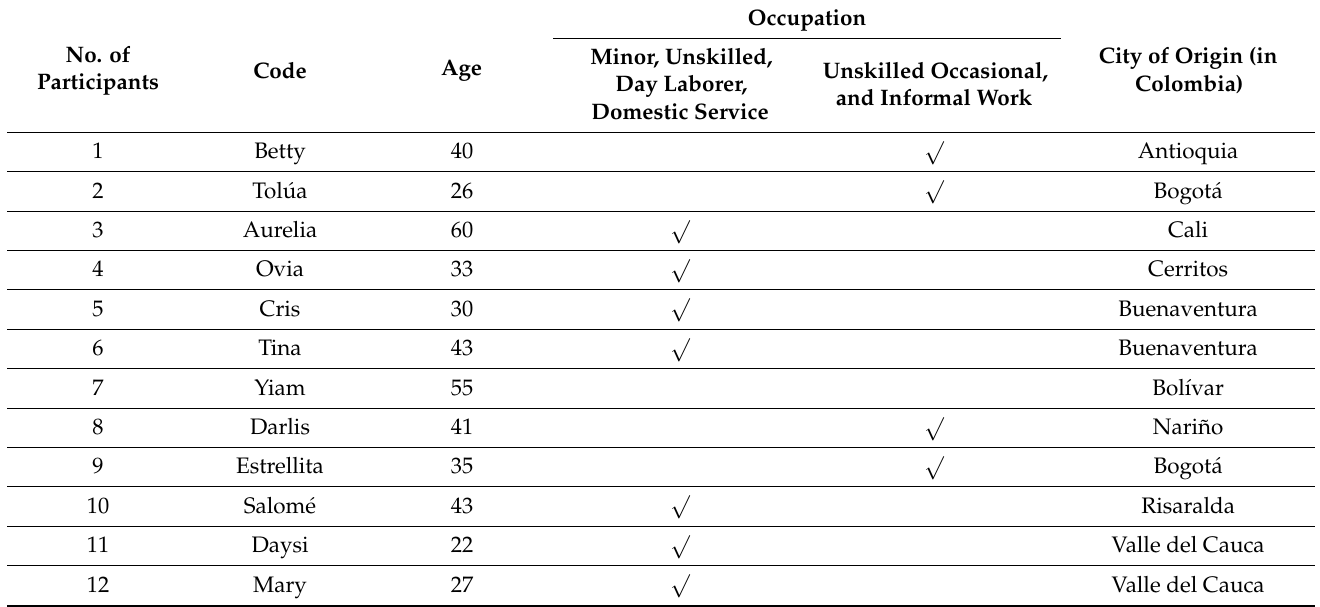
Table 1. Afro-Colombian women participating in the